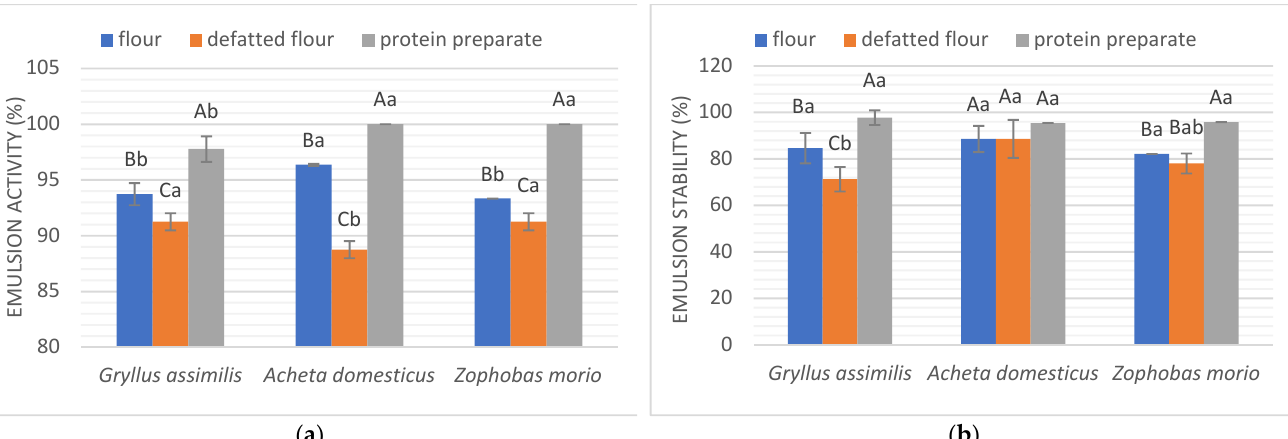
Figure 4. Emulsifying properties of studied insect forms. ( a ) Emulsion activity (%); ( b ) emulsion stability (%). Different letters in the same form of an insect (flour, defatted flour, protein preparation) indicate a significant difference ( p < 0.05). Different capital letters in the same insect species indicate a significant difference ( p < 0.05).